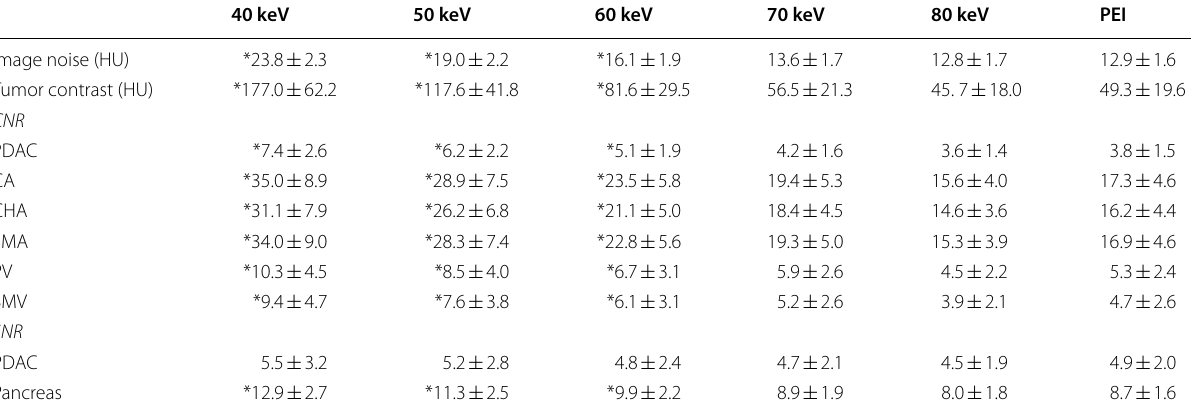
Data are expressed as mean SD ± PDAC, pancreatic ductal adenocarcinoma; HU, Hounsfield units; tumor contrast, HU pancreas artery; CHA, common hepatic artery; SMA, superior mesenteric artery; PV, portal vein; SMV, superior mesenteric vein *MEI ( ) > PEI in the quantitative image quality ( p < 0.05) +